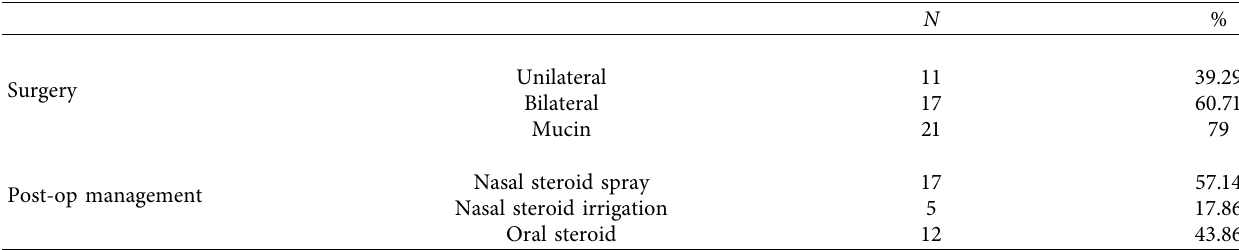
Table 4: Surgery side and post-op management results.